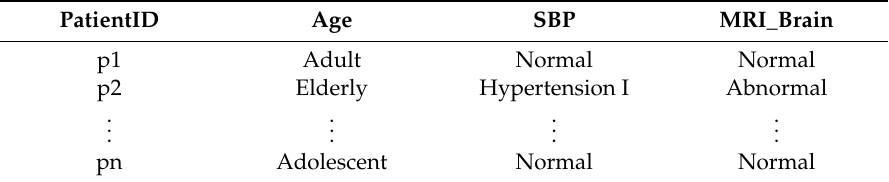
Table 1. An example of a cerebrovascular examination dataset in